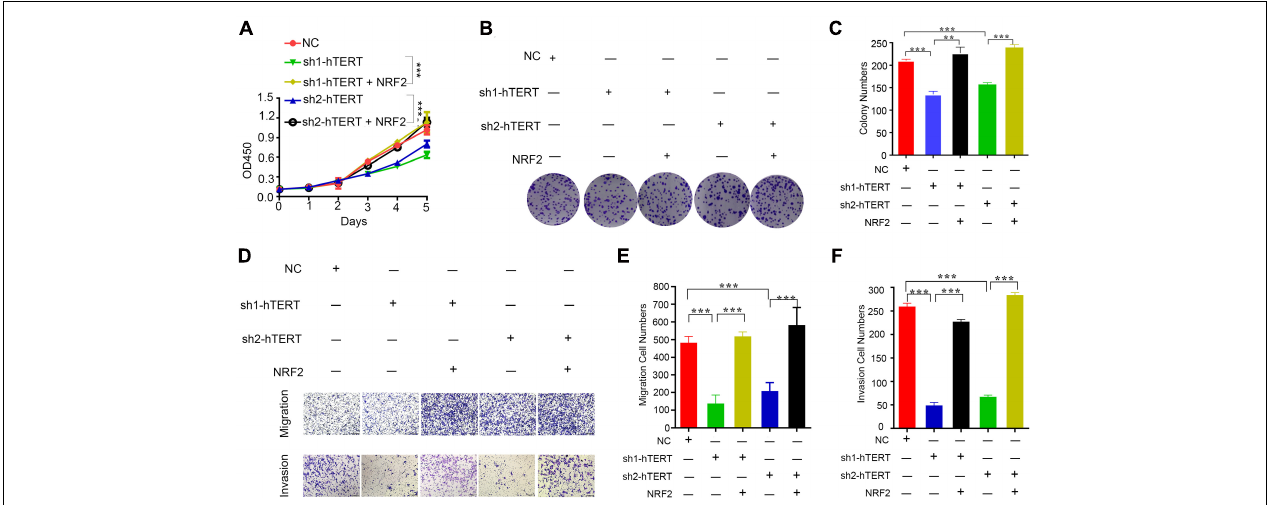
FIGURE 3 | Human telomerase reverse transcriptase (hTERT) promotes colorectal cancer cell proliferation and metastasis by upregulating NRF2. (A) CCK8 assays were performed to detect cell proliferation after downregulation of hTERT but an increase in NRF2 expression. (B) Colony formation assays were performed after downregulation of hTERT but an increase in NRF2 expression. (C) Statistical analysis of the colony numbers. (D) Migration and invasion assays were performed after downregulation of hTERT but an increase in NRF2 expression. (E) Statistical analysis of the migration cell numbers. (F) Statistical analysis of the invasion cell numbers. * p < 0.05; ** p < 0.01; *** p < 0.001; ns, no